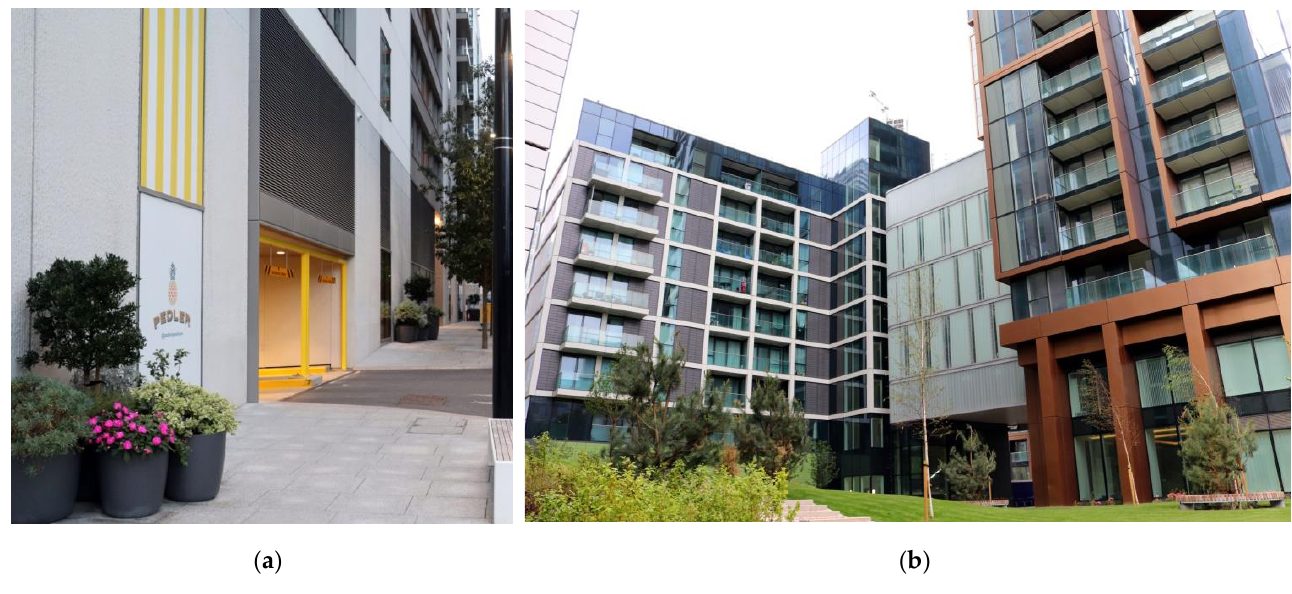
Figure 21. Colour and legibility. ( a ) Colour highlight of the car entrance in 10 Park Drive building (2021); ( b ) Colour distinguishing different sections of the Harbour Exchange development (2021).